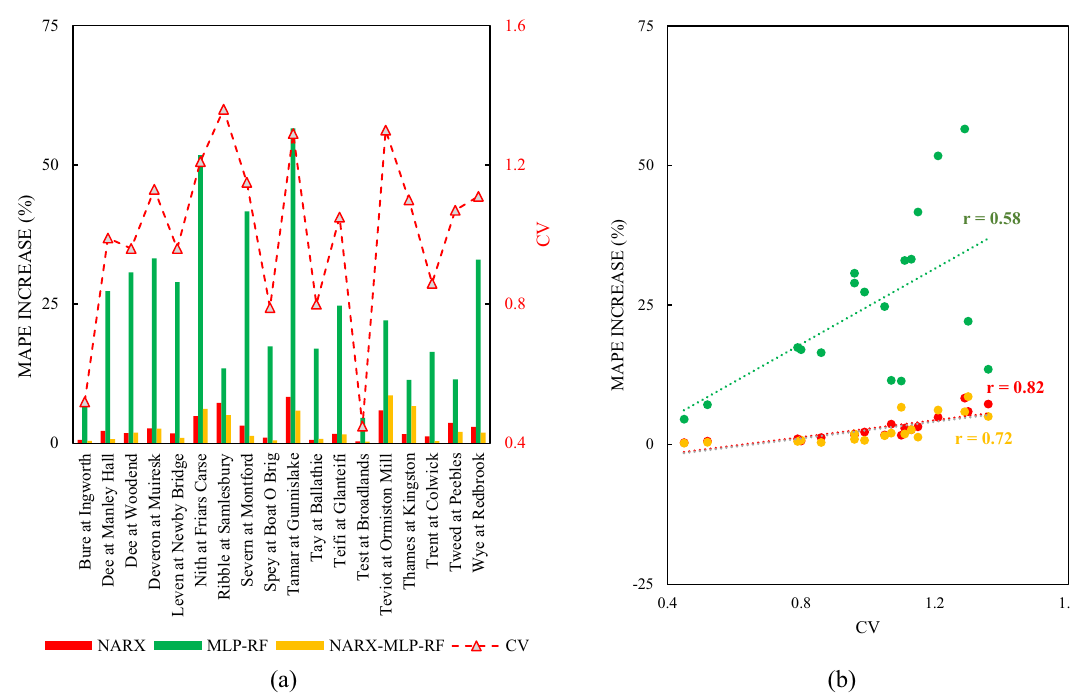
Figure 15. MAPE percentage increase as the forecast horizon increases: histogram for the 18 rivers ( a ); CV vs MAPE percentage increase ( b